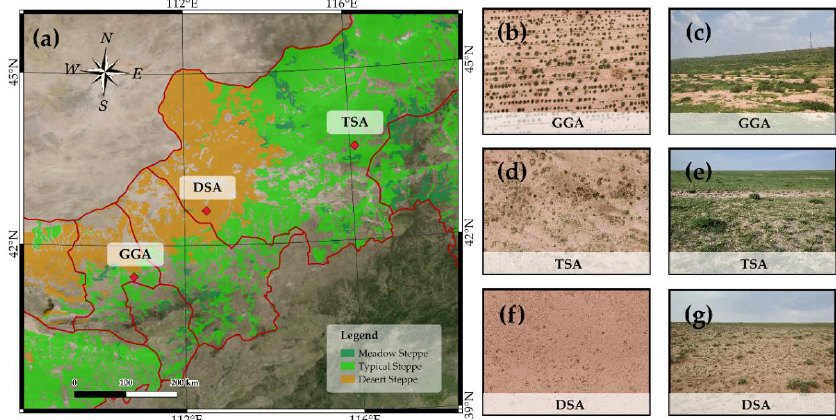
Figure 1. Experimental areas: ( a ) locations of the Grass for Green Test Area (GGA), the Typical Steppe Test Area (TSA) and the Desert Steppe Test Area (DSA); ( b , c ) unmanned aircraft system (UAS) image and photo of the GGA; ( d , e ) UAS image and photo of the TSA; ( f , g ) UAS image and photo of the DSA.